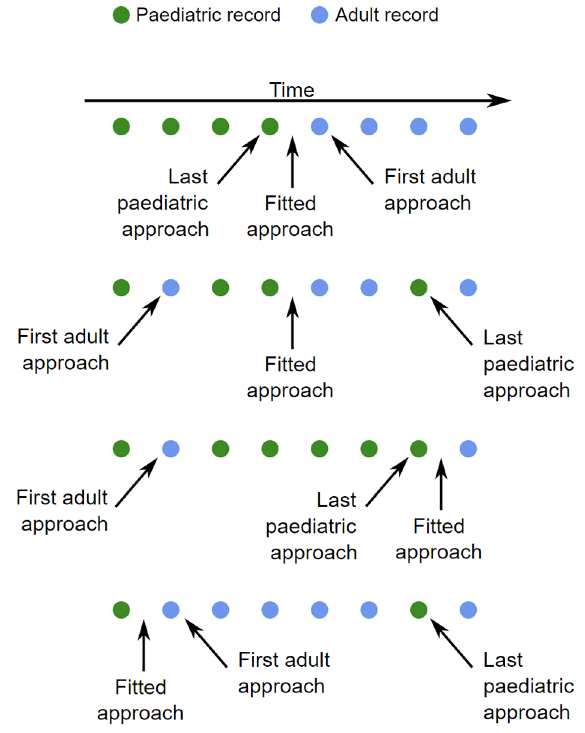
Figure 2: Estimation of transition points under different patterns of records (inpatient and outpatient) classified as paediatric or adult